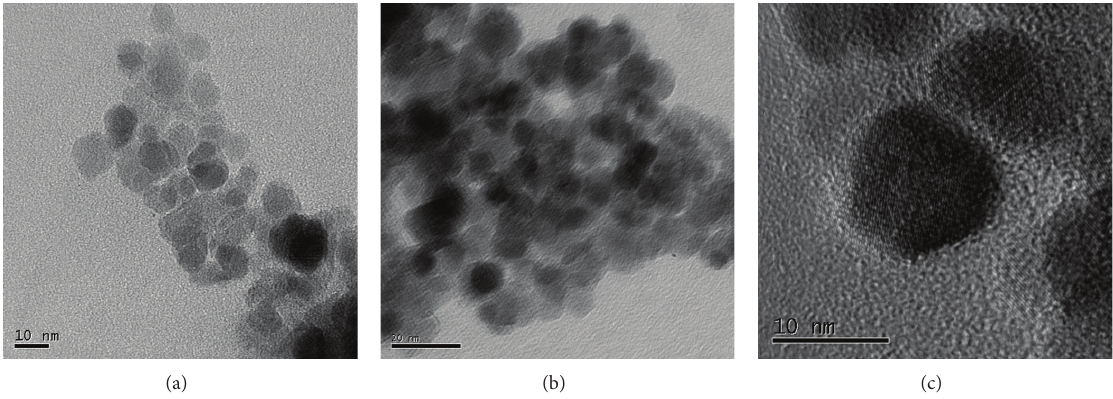
Figure 2: (a) TEM of Fe 3 O 4 , (b) TEM of MNP-DTIMPF 6 , and (c) HRTEM of MNP-DTIMPF 6 .